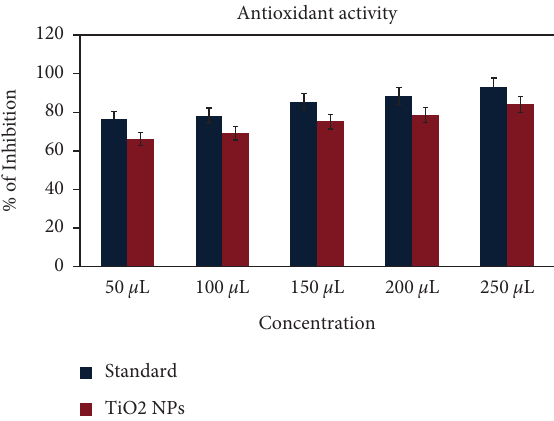
Figure 9: Antioxidant activity of TiO